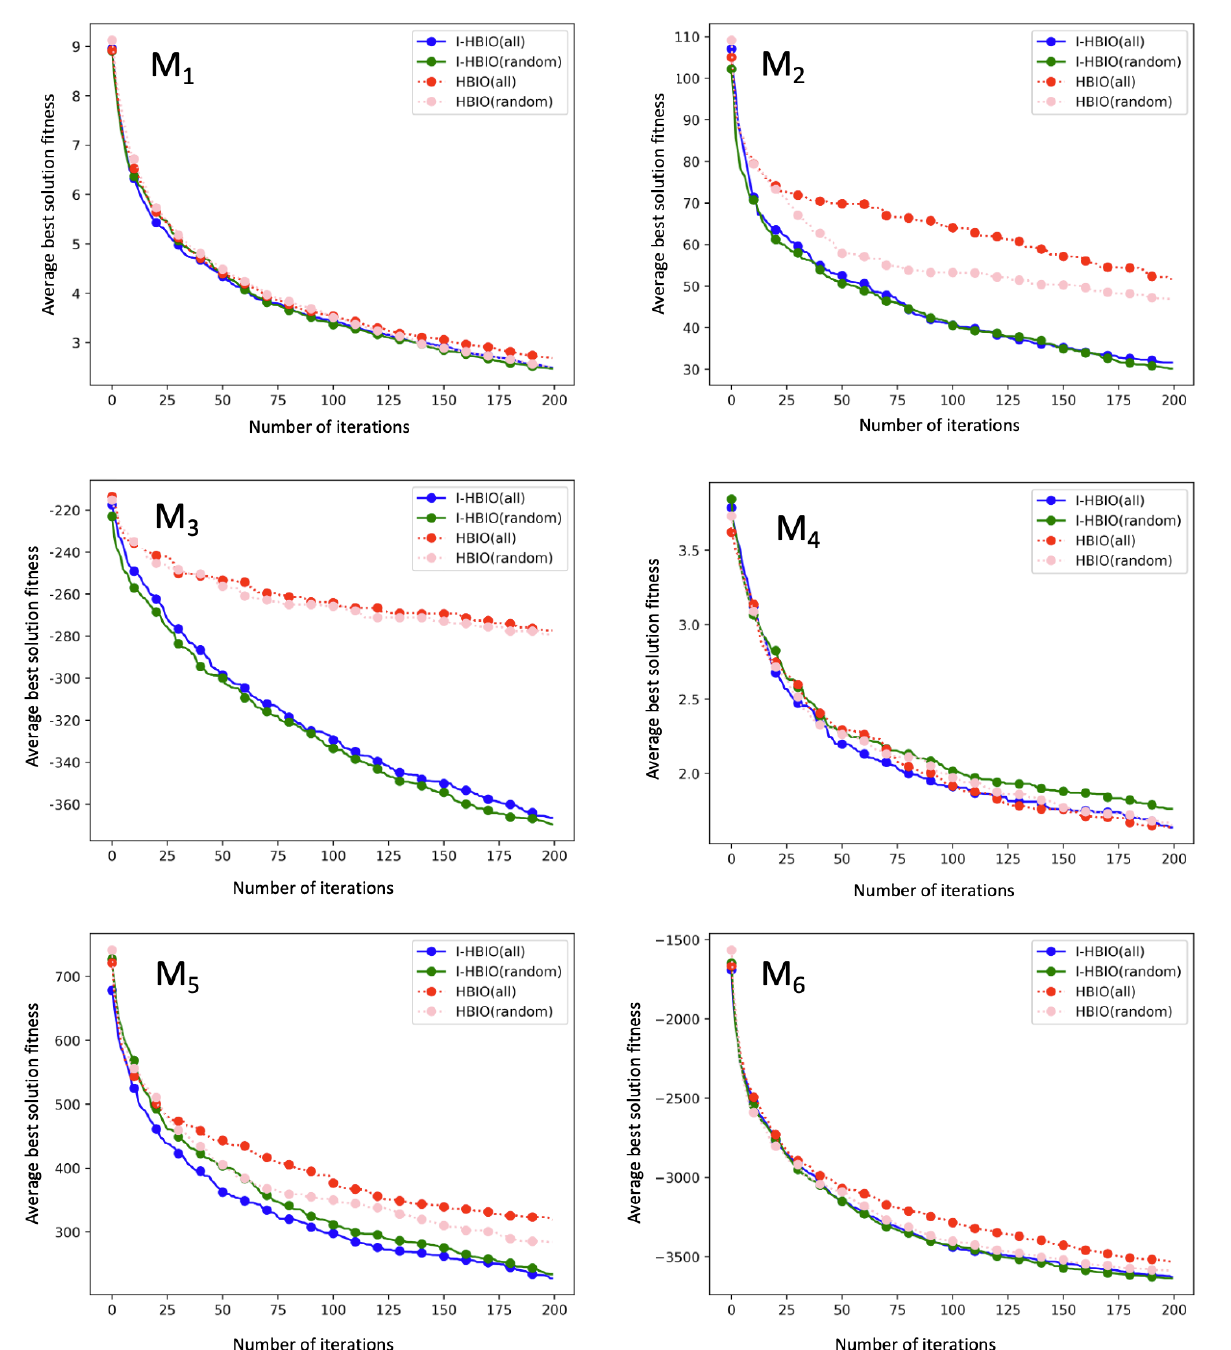
Figure 15. Optimization results on multimodal benchmark